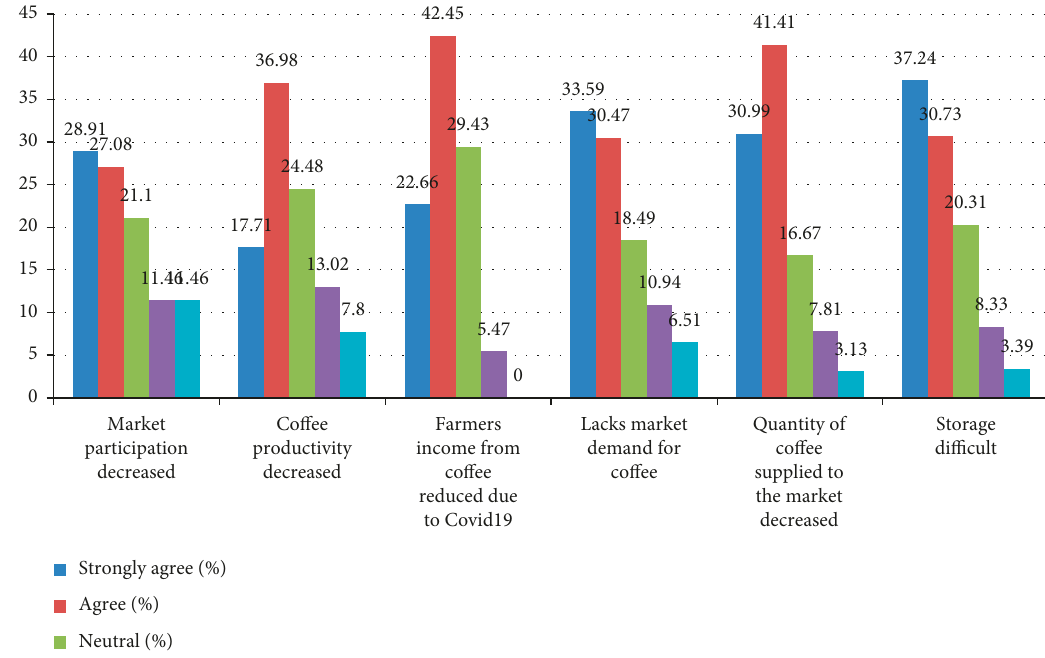
Figure 2: Respondents’ perception of the effects of